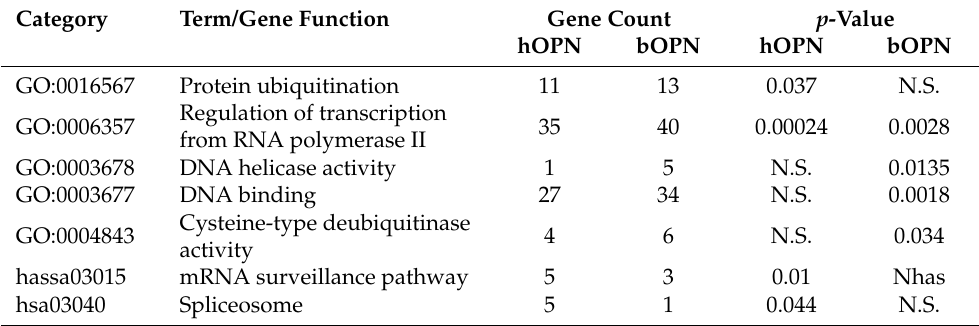
Table 4. Gene Ontology and KEGG pathway analysis of DEGs associated with Caco-2 cells after OPN